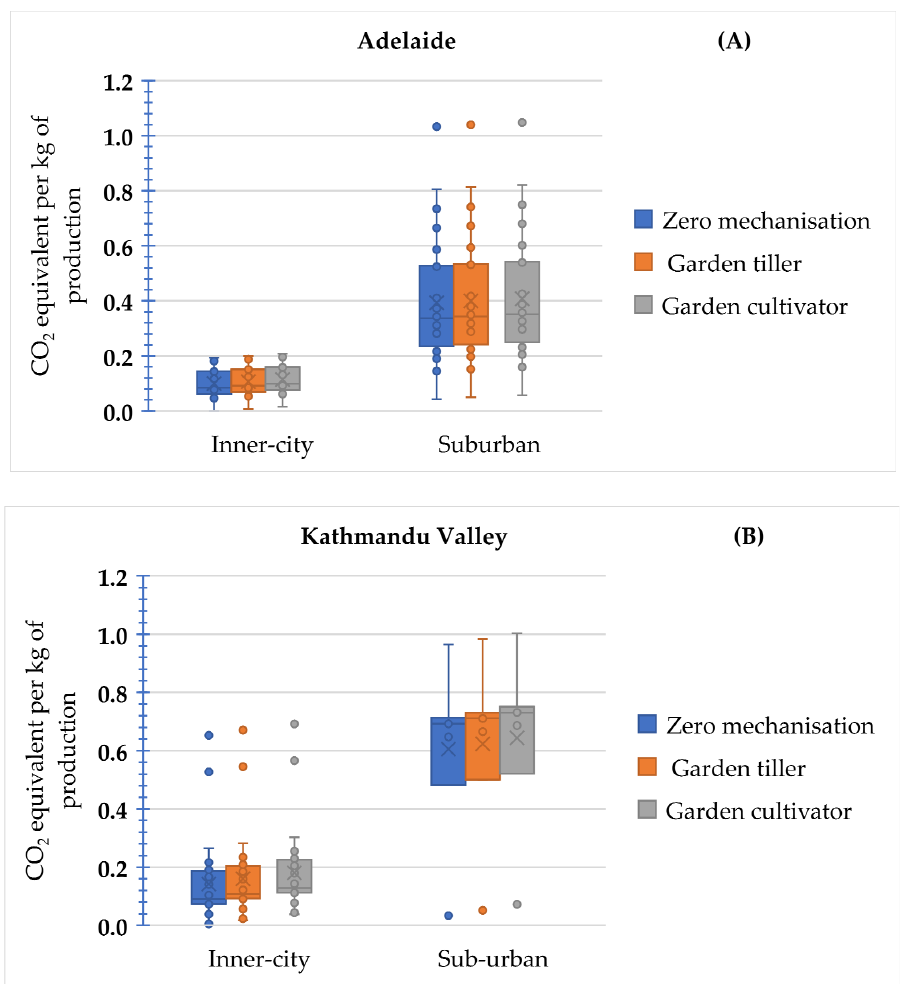
Figure 9. ( A , B ). Distance-wise carbon dioxide emission calculation in Adelaide and Kathmandu Valley. The X marker represents the average value, the horizontal line marks the median, the box marks the standard deviation, the extended lines (whiskers) mark the 5th and 95th percentiles, and the dots mark the outliers.